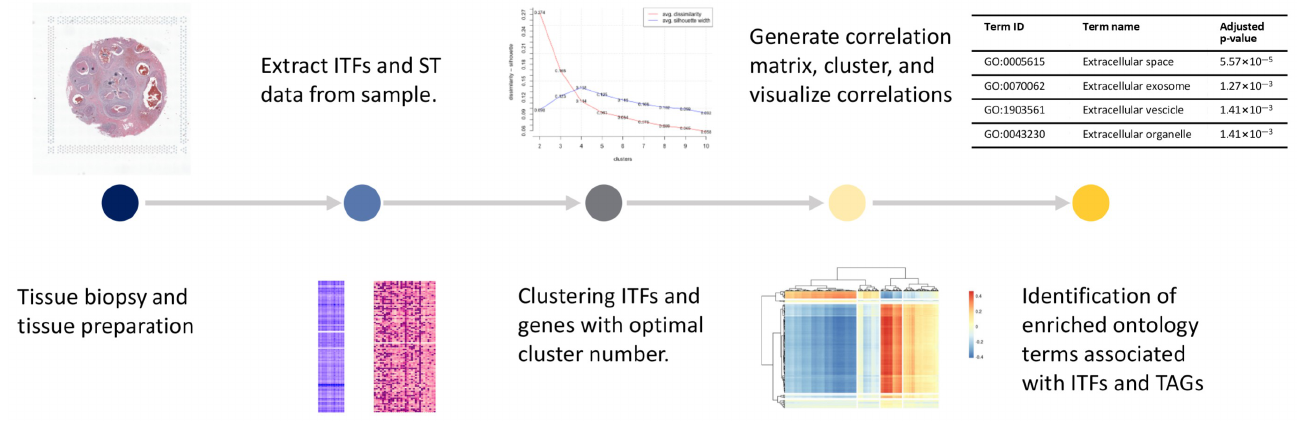
Figure 1. Workflow of the method from tissue preparation to identifying gene ontology terms associated with ITFs.